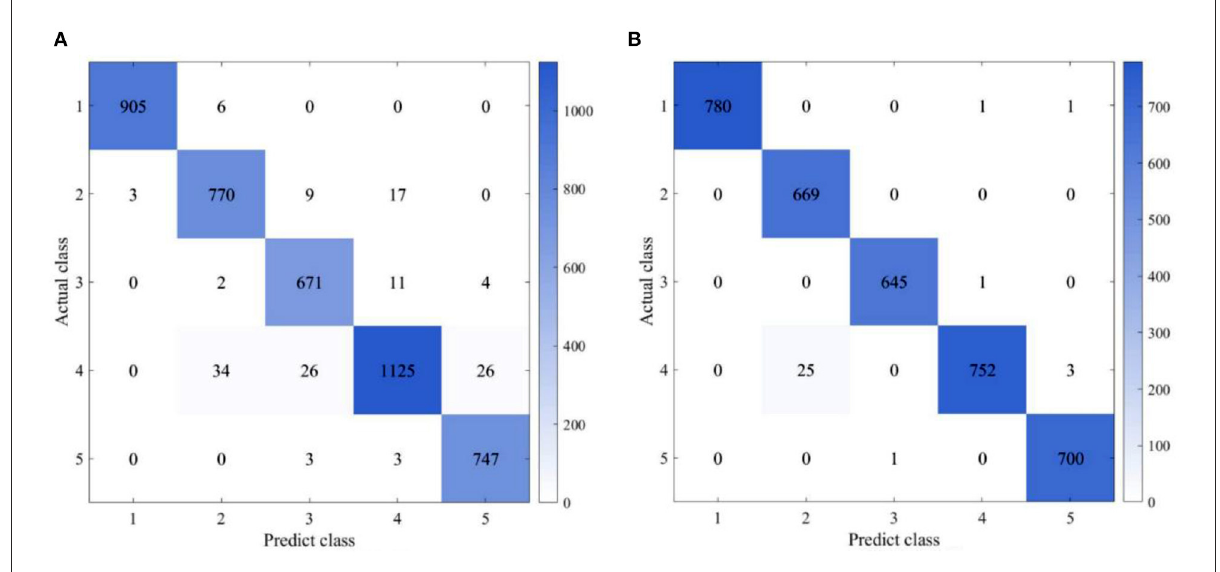
FIGURE8 Confusion matrix (LSTM-based classification; (A) 5ms and (B) 100ms).